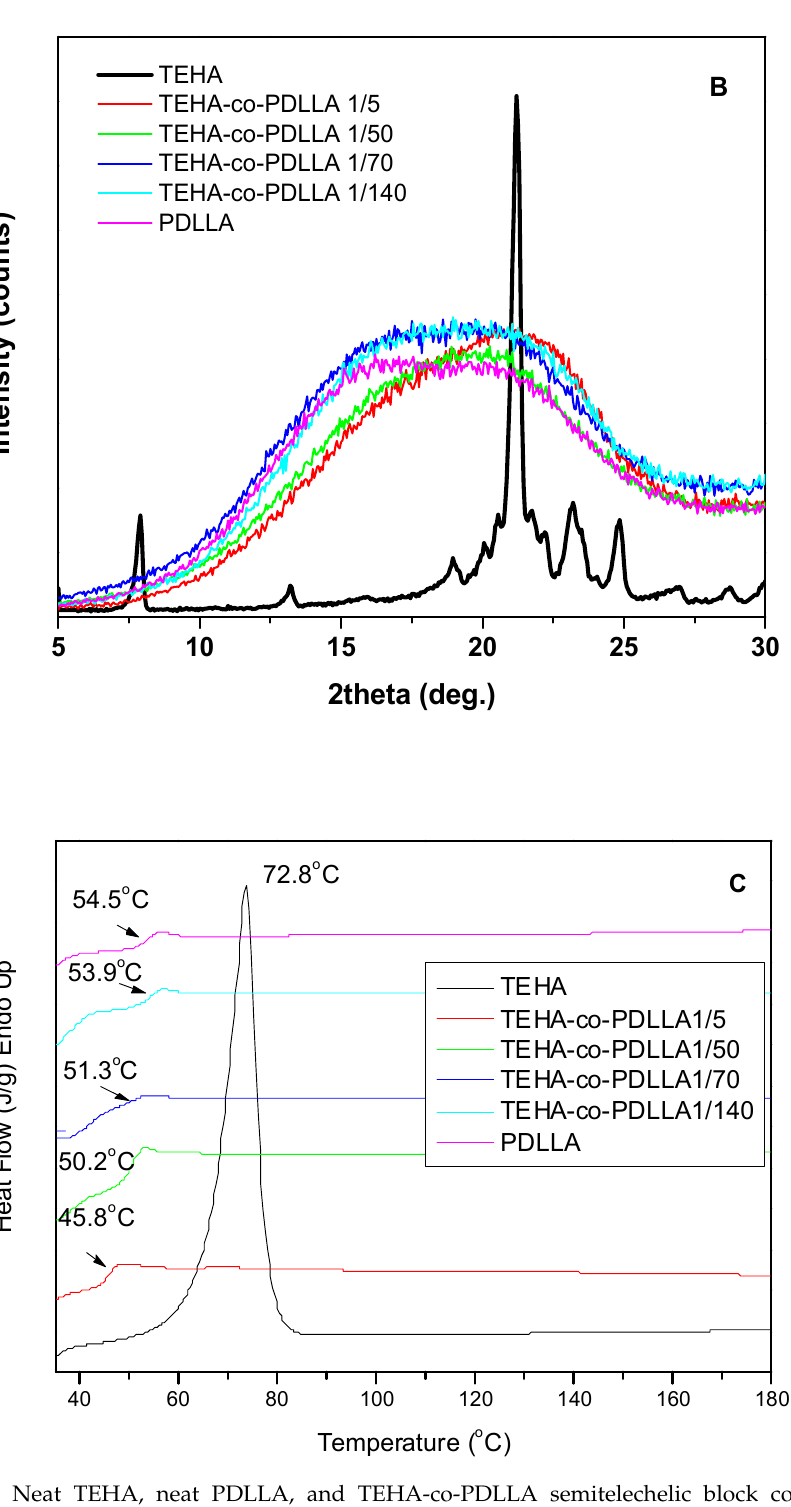
Figure 3. Neat TEHA, neat PDLLA, and TEHA-co-PDLLA semitelechelic block copolymers characterized via FTIR ( A ), XRD ( B ), and DSC second heat scan ( C ) analysis.